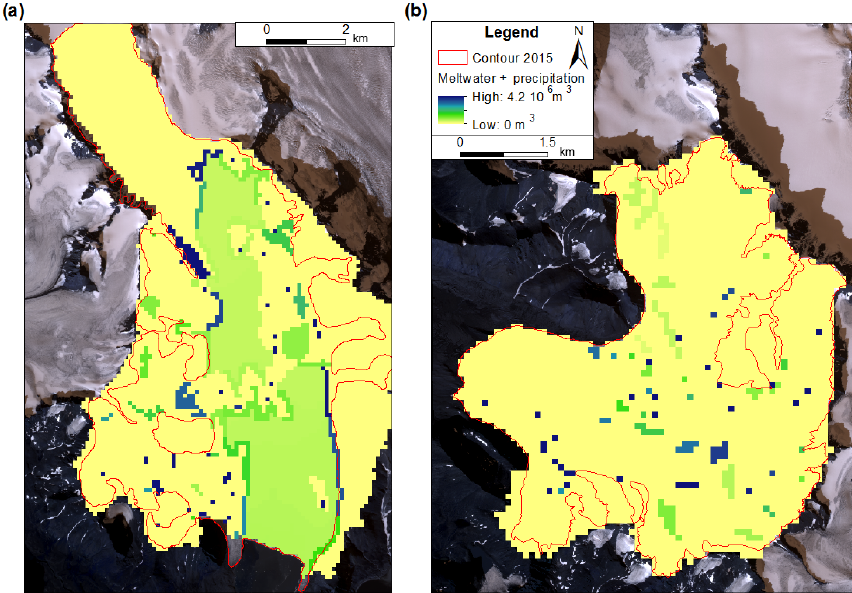
Figure 4. Discrete water recharge (meltwater and precipitation) for Hansbreen (a) and Werenskioldbreen (b) in 2015. The map background is a WorldView-2 VHRS image acquired on 21 August